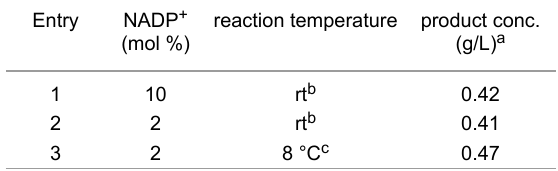
Table 1: Influence of reaction temperature and amount of cofactor on the enzymatic hydroxylation of n -octane. Entry NADP +